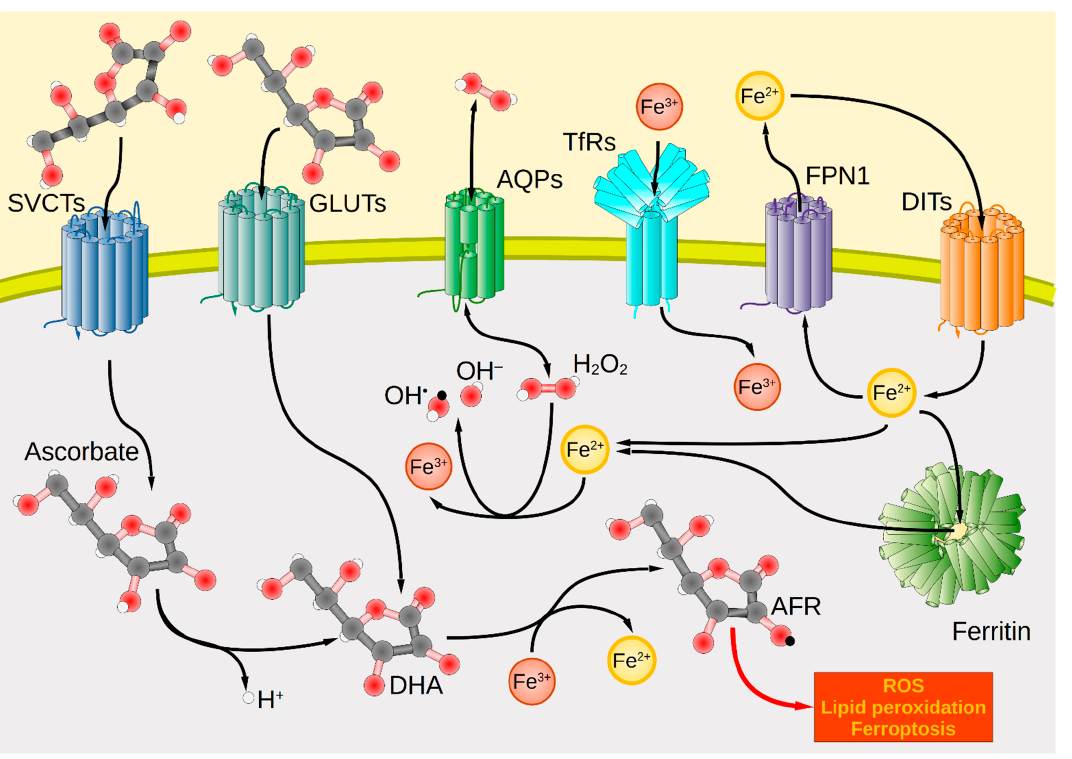
Figure 1. Transport systems for ascorbate, iron, and hydrogen peroxide across the plasma membrane and intracellular redox interactions in tumor cells. Cancer cells take up ascorbate via the transport proteins SVCT1 and SVCT2, whereas DHA uptake is mediated by GLUTs (GLUT1/3/4). Intracellularly, DHA is oxidized by Fe 3+ to form the AFR, increasing cellular oxidative stress. Extra- cellularly formed H 2 O 2 enters the cell interior through AQP membrane channels, where it forms hydroxyl radicals (OH•) under the catalytic action of Fe 2+ as part of the Fenton reaction. These lead to the generation of further ROS, lipid peroxidation, and ultimately cell death. Iron import occurs by TfR via endocytosis for Tf-bound ferric iron (Fe 3+ ) or in the case of unbound ferrous iron (Fe 2+ ) by various DITs, e.g., DMT1. In contrast, iron export occurs through FPN1. Intracellularly, iron is present predominantly in the form of Fe 2+ bound to ferritin. Red spheres symbolize oxygen atoms; black spheres carbon atoms; white spheres hydrogen atoms. Black arrows mark the direction of transport or reaction. AFR, ascorbate free radical; AQP, aquaporin; DHA, dehydroascorbic acid; DIT, divalent iron transporter; DMT1, divalent metal transporter 1; FPN1, ferroportin 1; GLUT, glu- cose transporter; ROS, reactive oxygen species; SVCT, sodium-dependent vitamin C transporter; Tf, transferrin; TfR, Tf receptor. Ascorbate has a complex chemistry, enables the reduction of Fe 3+ , and facilitates iron uptake (Figure 2) [277].